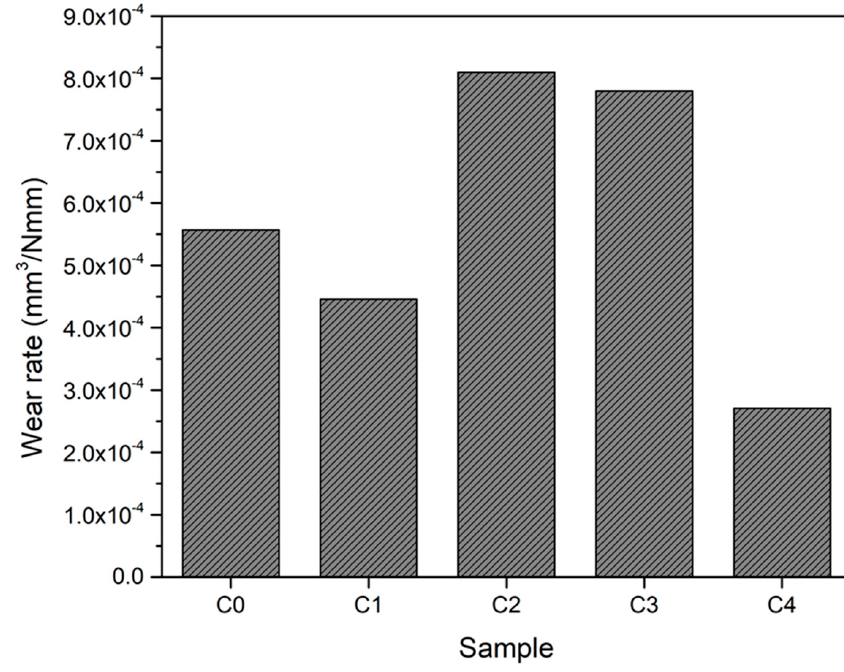
Figure 7 . Volumetric wear rate of the cast samples .